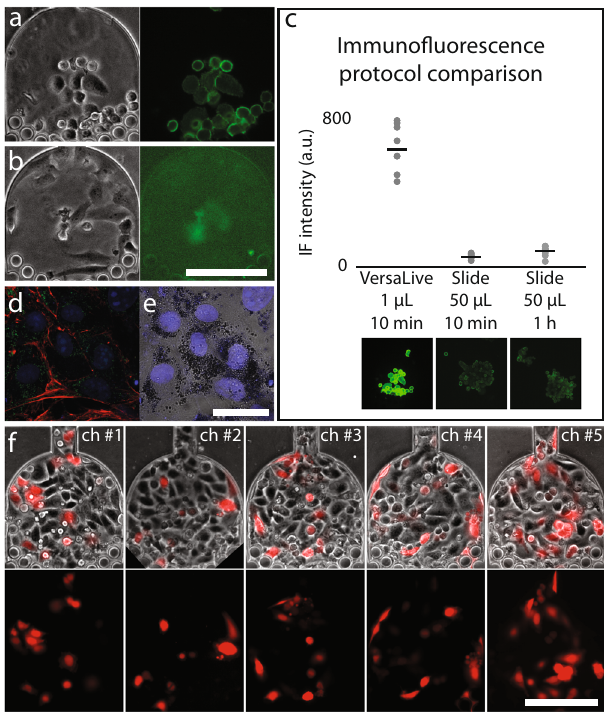
Fig. 3 Immuno fl uorescence (IF) and plasmid transfection on VersaLive. a , b On-chip immuno fl uorescence of HER2 membrane receptor on AU565 cells (a, positive control) and HCC38 cells (b, negative control). Scale bar, 150 µ m. c Comparison of the IF signal intensities for immuno fl uorescence staining on VersaLive and on slide using a standard protocol. Compared to standard slide protocols, IF on VersaLive resulted in a 10-fold increase in signal while shortening the process time and decreasing reagent consumption. Black bars represent the median values of single ROIs (gray dots, n = 8). d , e Culture of primary mouse retina pigmented epithelium (RPE) cells. On-chip chemical fi xation and immunostaining, labeling of citrate synthase (green), f-actin (red), and cell nuclei (blue). The RPE cells were able to adhere to the chip while retaining their characteristic dark pigment. Scale bar, 30 µ m. f On-chip plasmid transfection of HeLa cells, chamber #1 to chamber #5 (ch#n) of the same chip. Transfection ef fi ciency of 25.3 ± 8.8% (mean ± s. d., n = 5). Scale bar, 150 μ